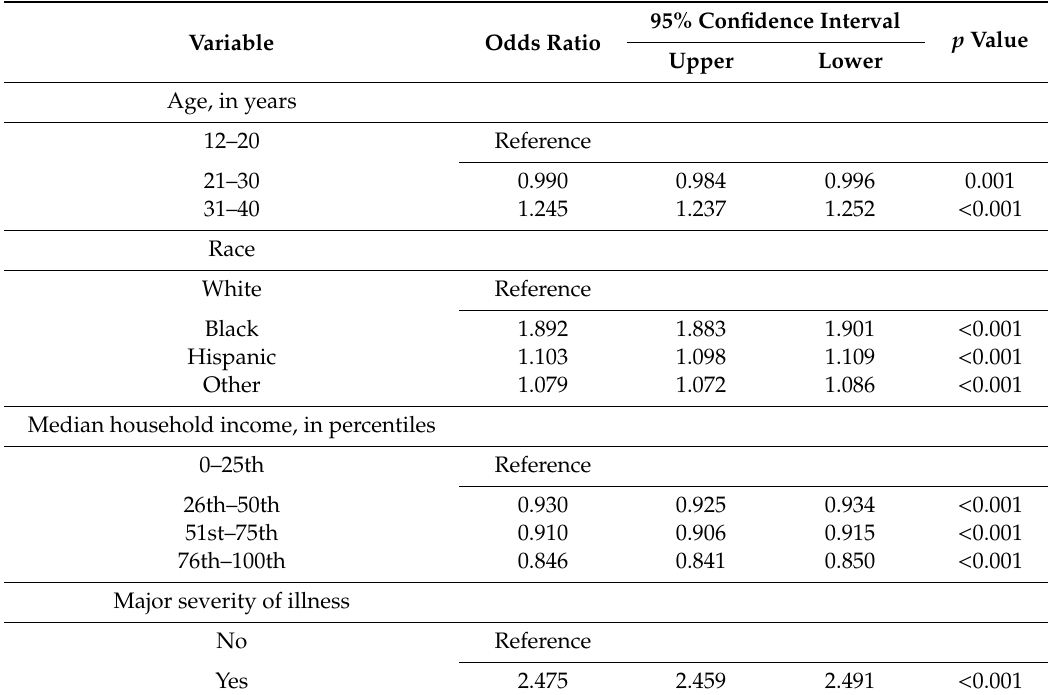
Table 2. Odds of major severity of illness due to antepartum mental disorders.